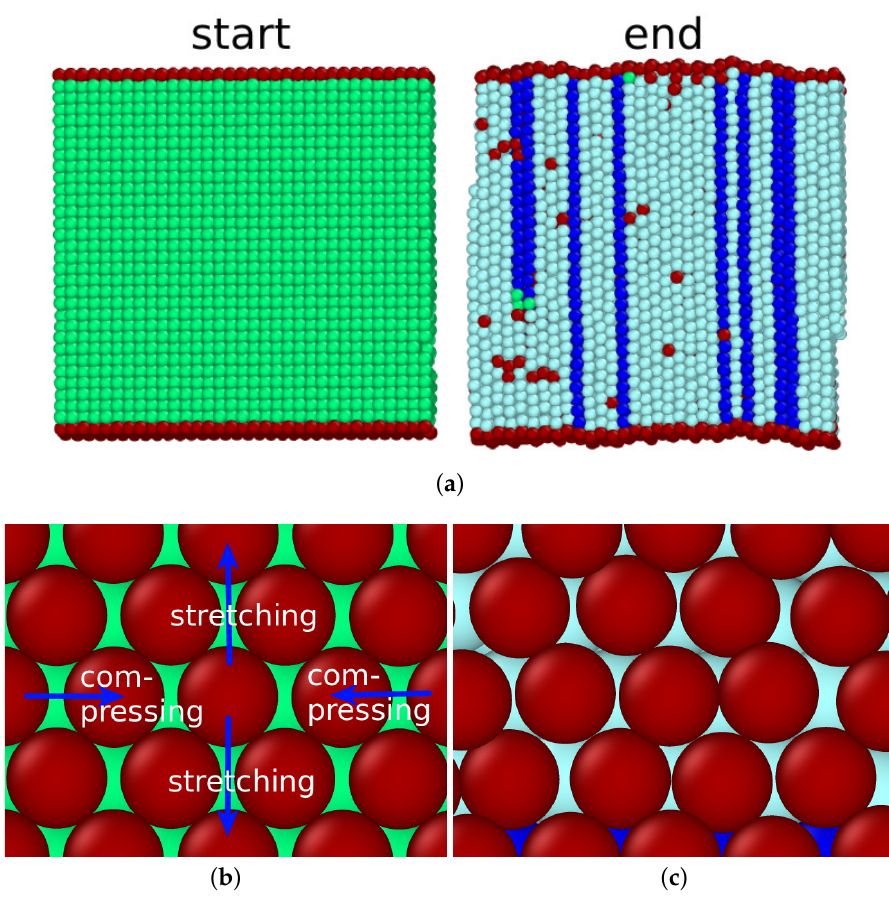
Figure 3. Austenitic transformation of a thin-film bcc Fe slab with a (110) surface: ( a ) side view of the film before and after the transformation; ( b ) top views of the film before the transformation; and ( c ) top views of the film after the transformation. The blue arrows highlight the directions, in which the crystal is compressed or stretched during the transformation. Colors denote the local lattice structure as in Figure